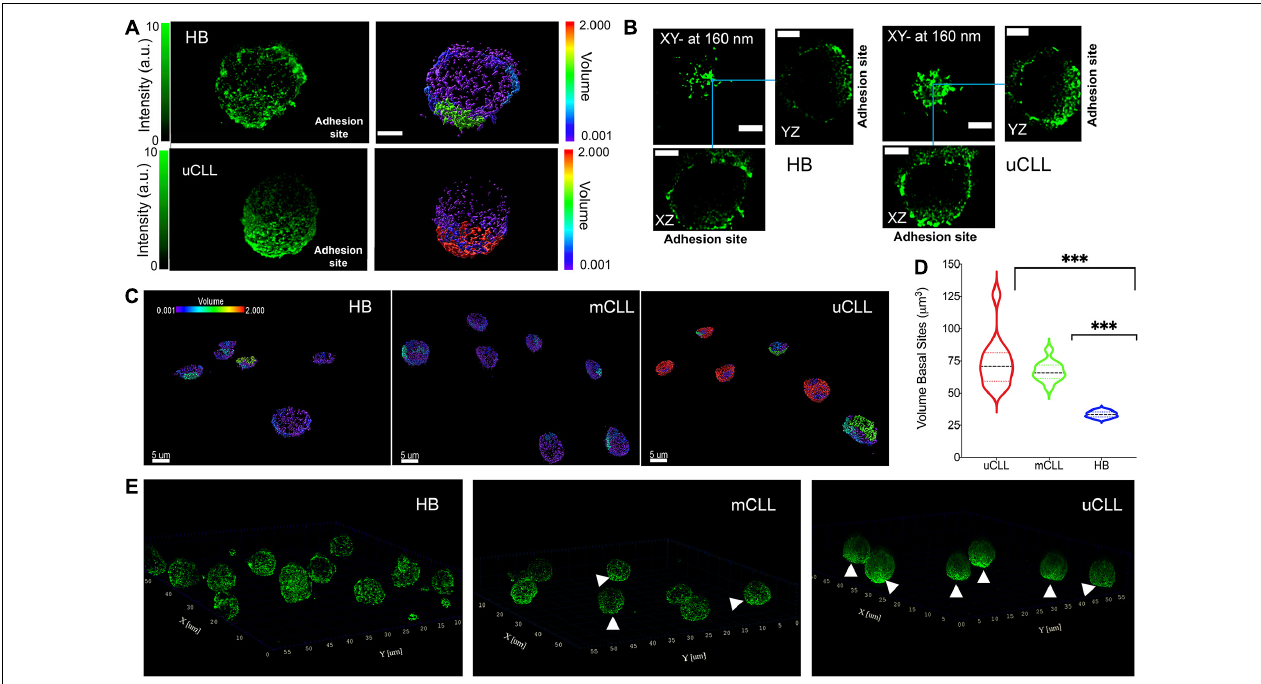
FIGURE 3 | Concentration gradient of HS1 clusters toward the adhesion sites. (A) Representative 3D rendering of STED Z-stacks acquired on a single HB and uCLL cells. The fluorescence intensity (green pseudo color) is compared with the cluster size reconstruction by IMARIS software (rainbow pseudo color in µ m 3 ). Scale bar 2 µ m. (B) Orthogonal projections of the cells shown in (A) from 0 to 160 nm above the basal side. Blue lines indicate the orthogonal cross. Scale bar 2 µ m. (C) Representative 3D rendering of STED Z-stacks acquired at the lowest planes above the coverslip and over a field of view of six or seven cells in parallel experiments. HS1 accumulates in unresolved assemblies in cells obtained from a patient with poor prognosis (uCLL) compared to the more homogeneous cluster distribution of the protein in healthy B cells (HB) and in CLL cells from a patient with good outcome (mCLL). The volume pseudo rainbow scale is in µ m 3 . (D) Violin plot distributions of the cluster size at basal side. HB 7 cells, median 33.5, interquartile 31.6/35.6; mCLL cells 13 from two patients, median 65.5, interquartile 61.4/71.8; uCLL cells 13 from two patients, median 77.8, interquartile 59.3/81.2. Two way ANOVA ∗∗∗ P = 0.0003. (E) Whole-cell 3D-rendering of STED Z-stacks showing the distribution of endogenous HS1 in healthy B (HB) and CLL cells obtained from patients with good (mCLL) or poor (uCLL) prognosis. The white arrows point to the HS1